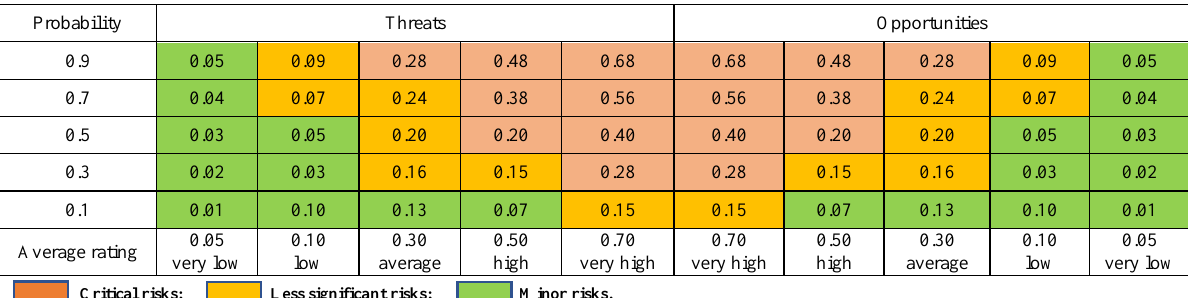
Table 1. The risk matrix of the investment